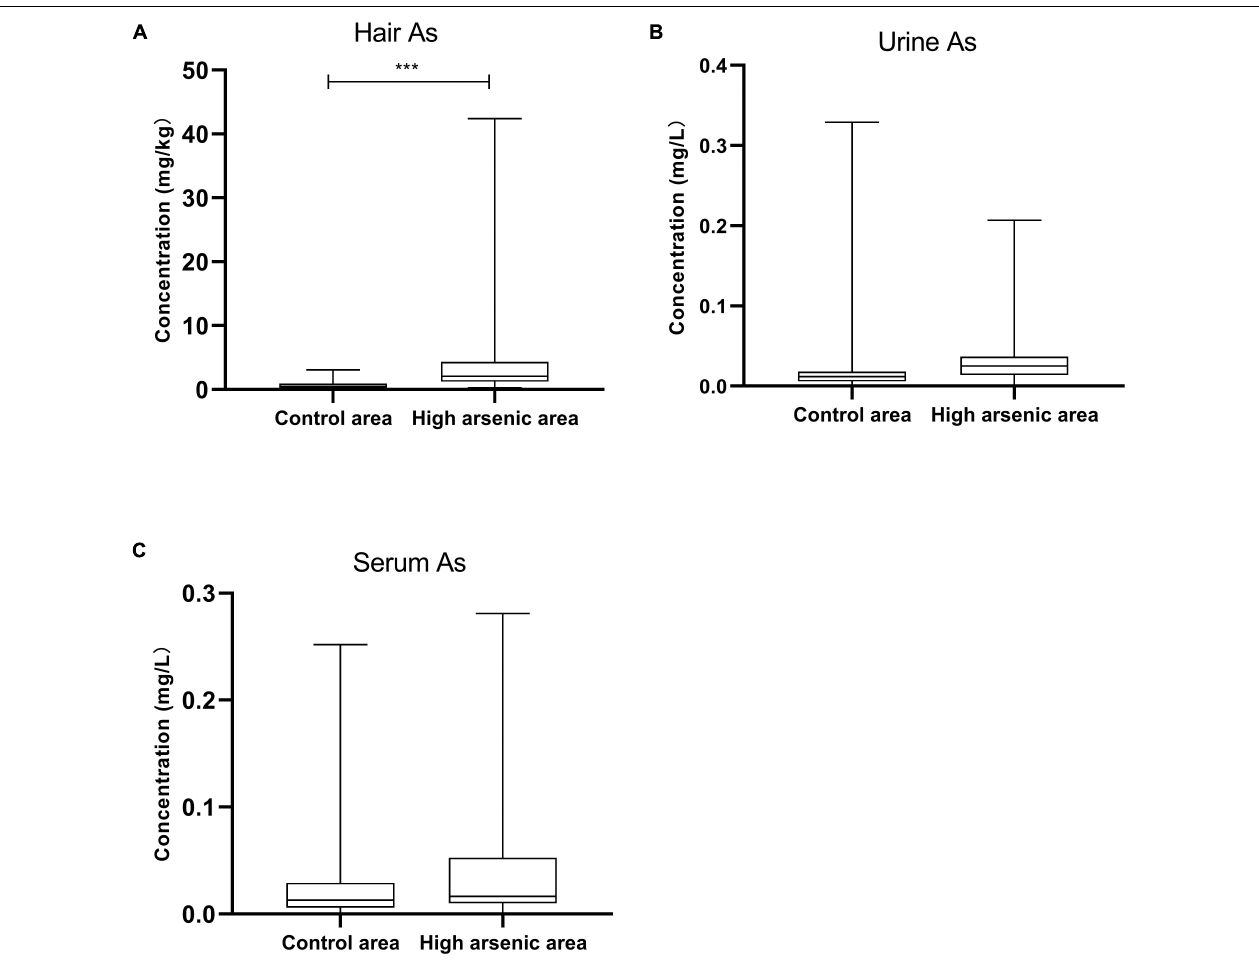
FIGURE 3 | Arsenic content of hair, urine, and serum in Ziyang County and the control area. Data are represented by median (M) and quartile range (QR). The comparison was performed by the non-parametric rank-sum test. *** p <